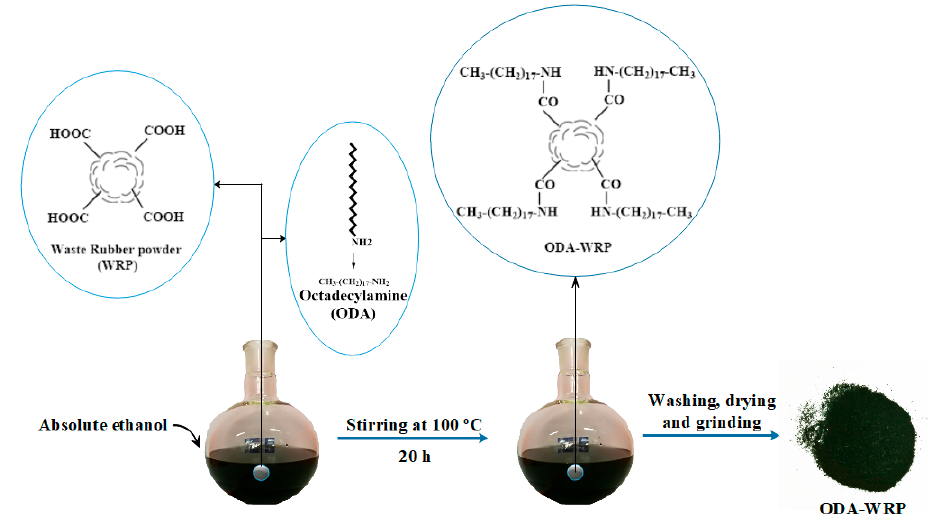
Figure 1. Preparation process of octadecyl amine grafted over waste rubber powder (ODA-WRP).